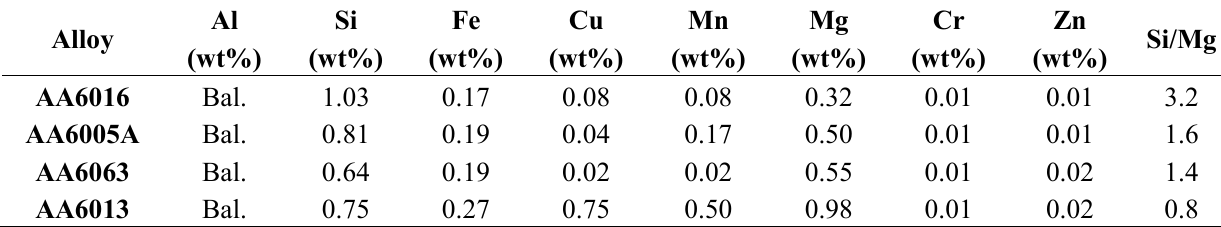
Table 1. Chemical composition of the investigated